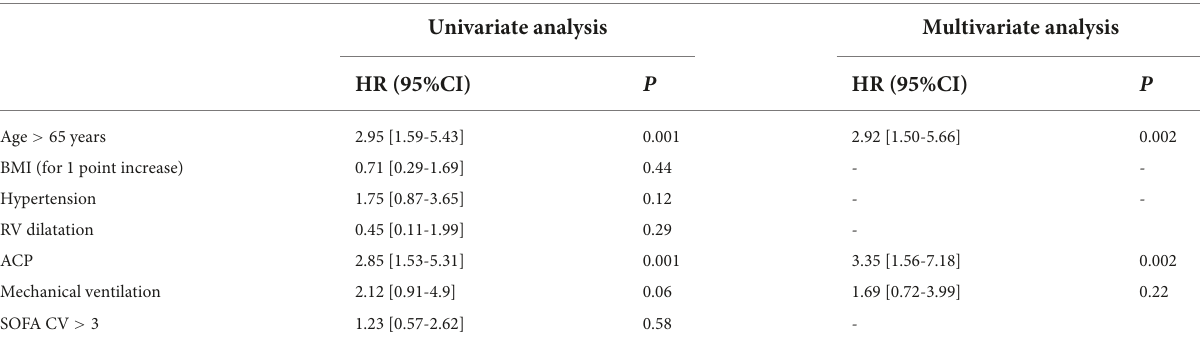
TABLE 5 Univariate and multivariate Cox regression analyses of predictive variables correlated with 30-day mortality in patients with COVID-19-related pneumonia.